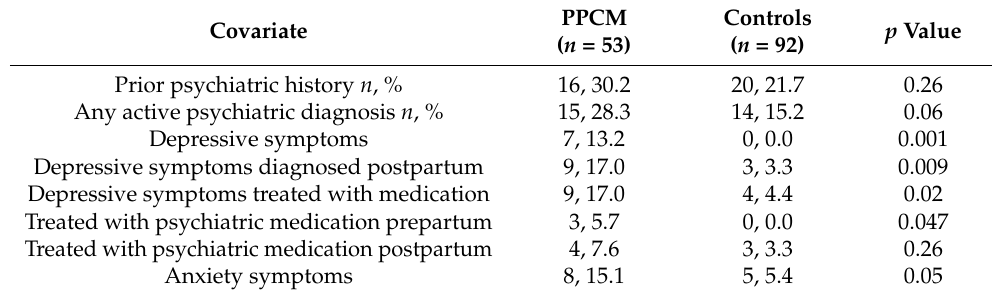
Table 2. Psychiatric history of women with PPCM ( n = 53) vs. age and race-matched controls ( n = 92). Covariate